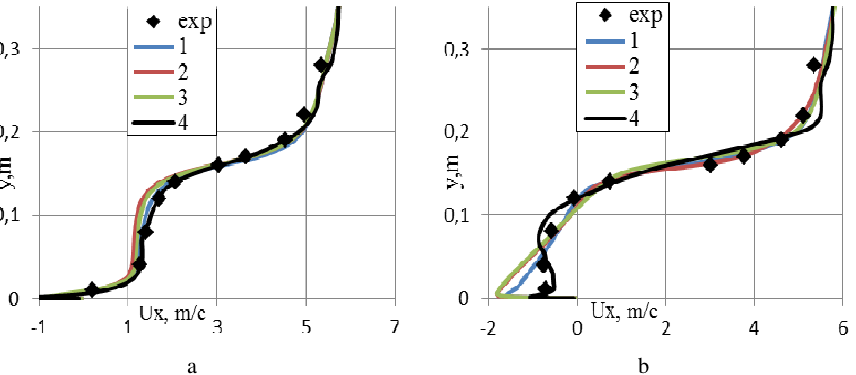
Fig. 4. Profiles of mean velocity Ux in the sections ( а ) X1 and (b) X2obtained from experimental data and in numerical calculations with the various turbulence